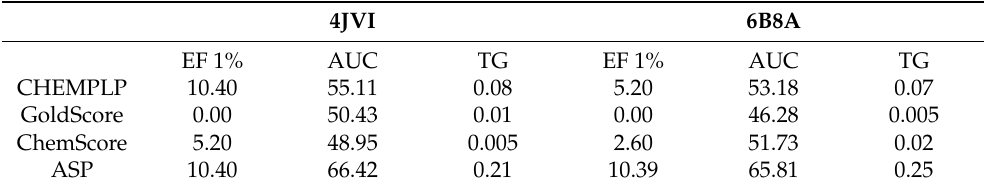
Table 1. Evaluation metrics for virtual screening results for X-ray structures for MvfR (4JVI and